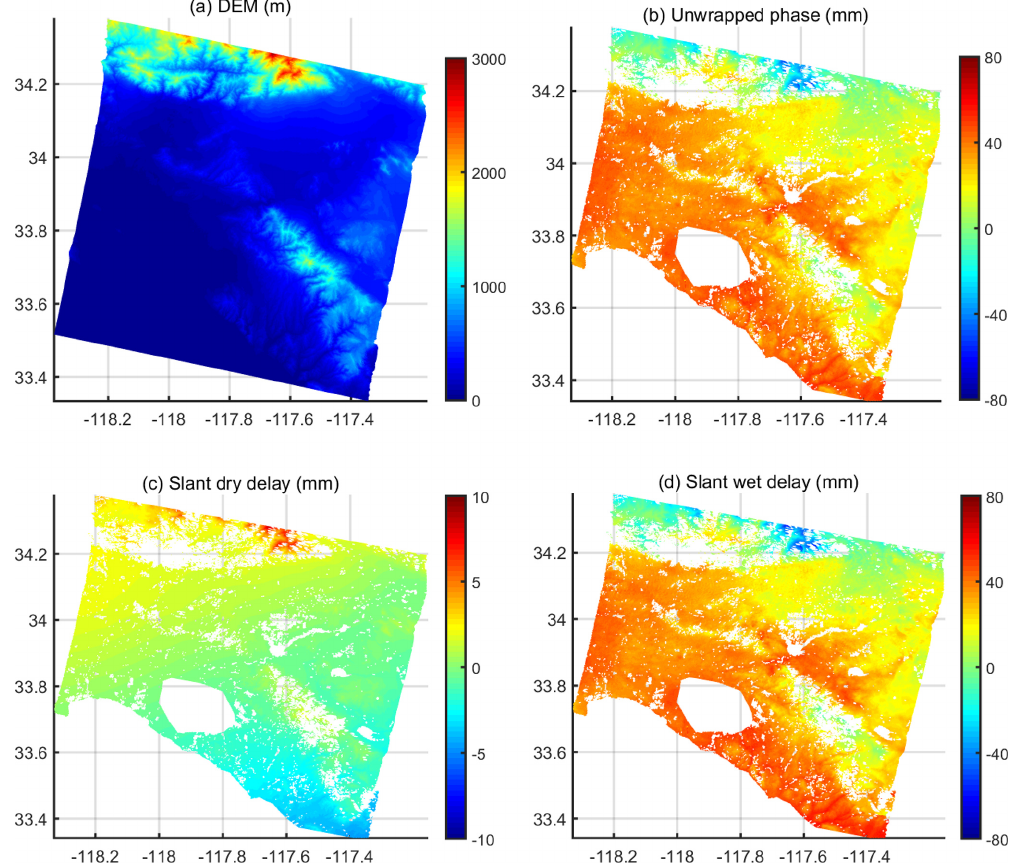
Figure 2. (a) Regional land topography from SRTM at interferogram pixels. (b) Unwrapped phase of differential interferogram (master image from 16 August 2008, slave image from 25 October 2008). (c) Slant hydrostatic delay difference maps predicted from the ERA- Interim model. (d) Slant wet delay difference obtained by subtracting (c) from (b) . The rapidly subsiding areas are masked out in (b) , (c) and (d)